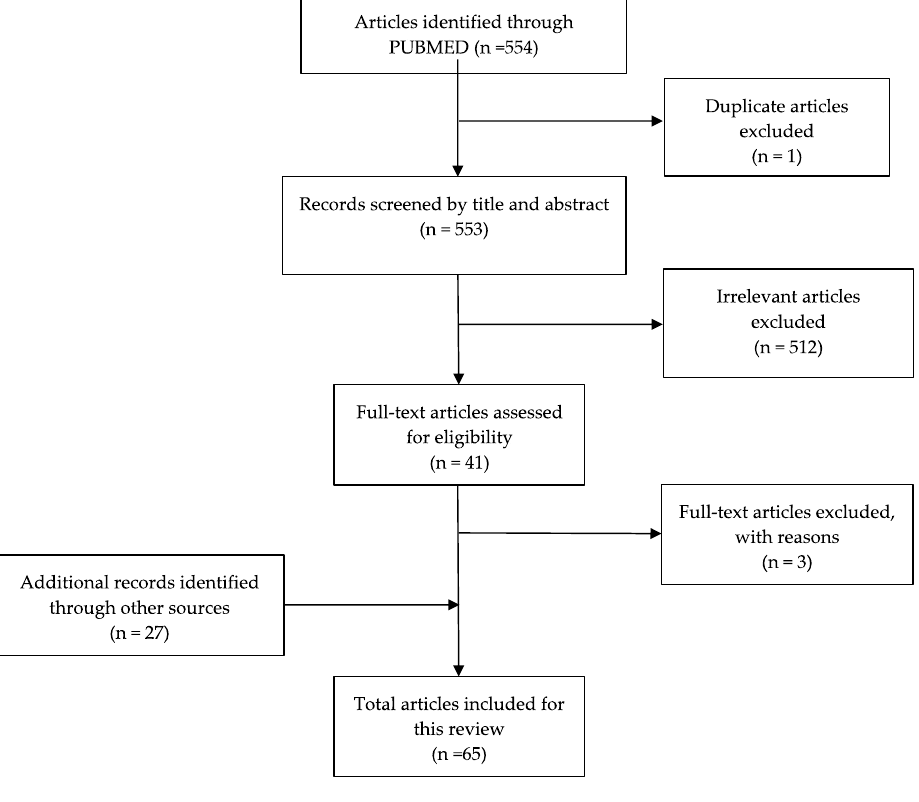
Figure 1. Process flow diagram.